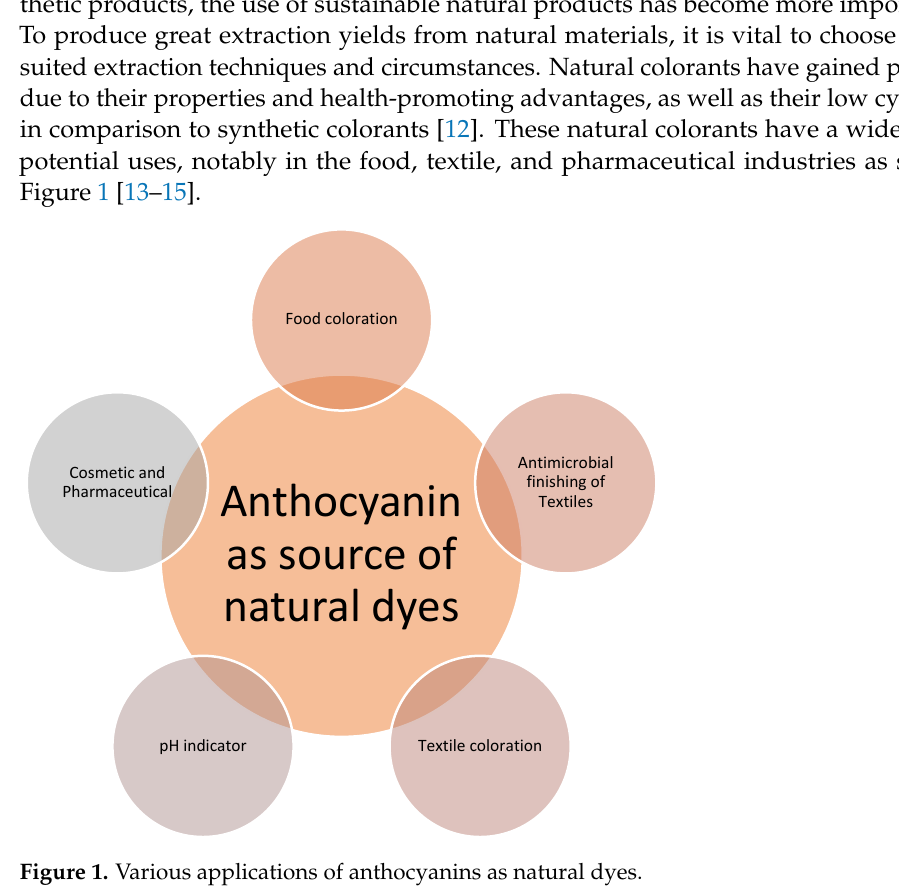
Figure 1. Various applications of anthocyanins as natural dyes.